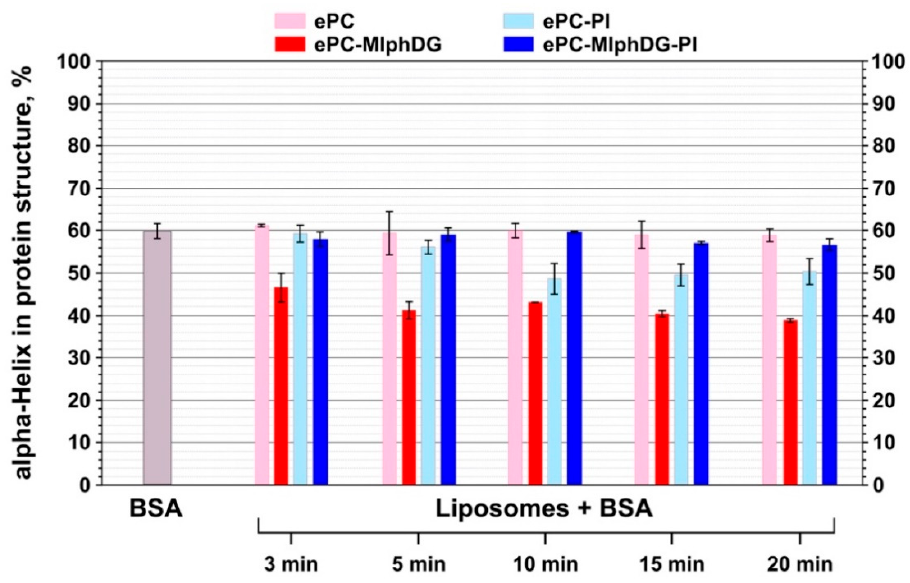
Figure 7. Changes in the percent of α -helices in the structure of BSA during interaction with lipo- somes of different compositions. Mean values ± SE of two independent experiments are presented.